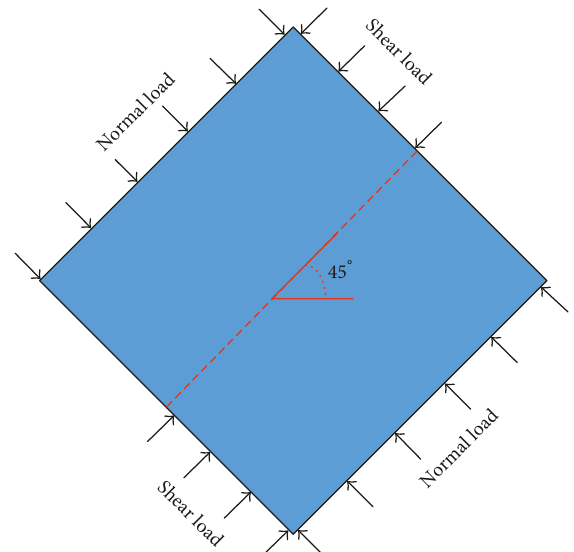
Figure 4: Diagram of stress